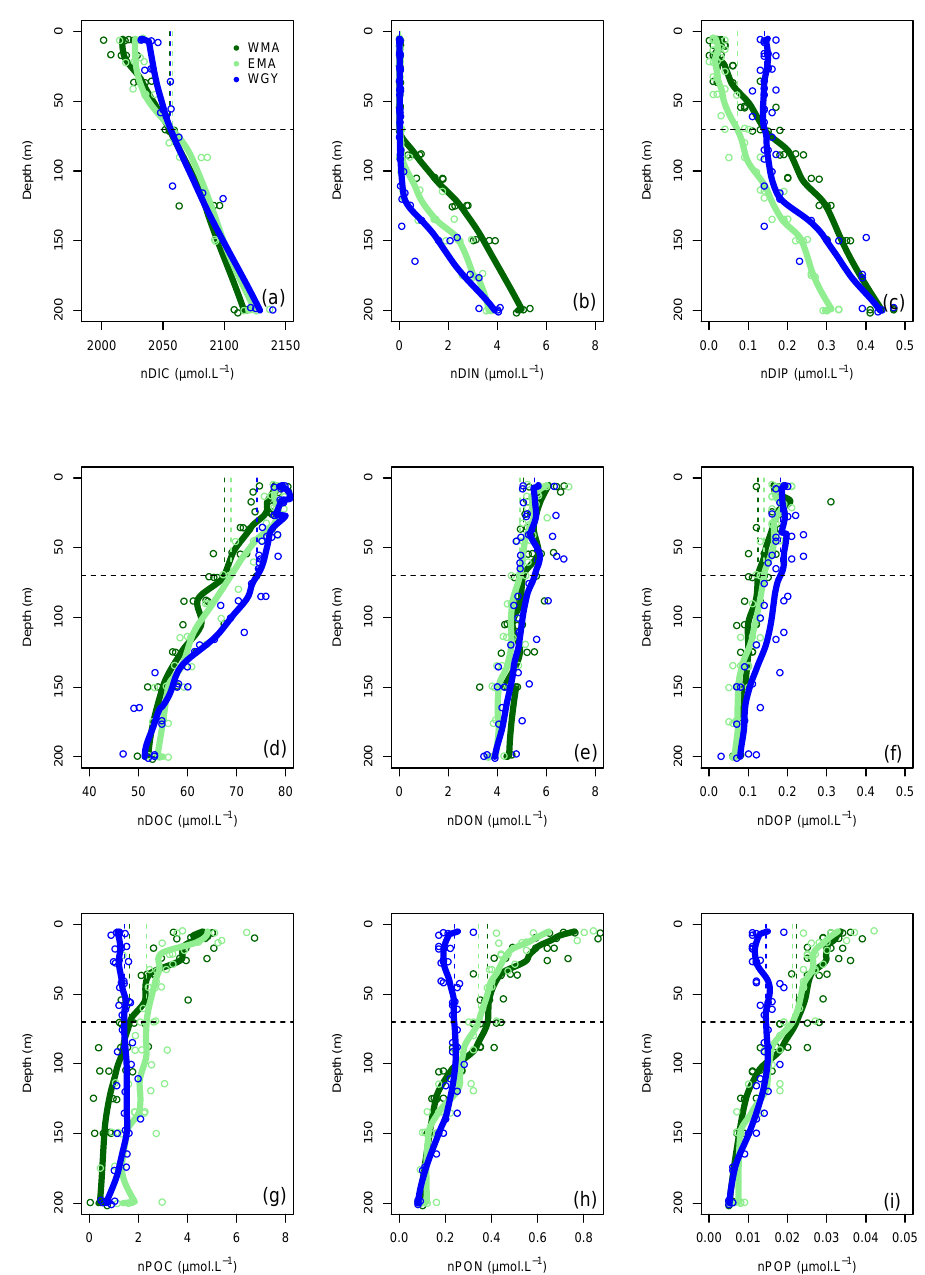
Figure 5. Vertical profiles of normalized (n) C, N, and P data against depth (m). Dissolved inorganic (DI), dissolved organic (DO) and particulate organic (PO) C (a, d, g) , N (b, e, h) , and P (c, f, i) , respectively, in µmolL − 1 , for the three distinct areas sampled during the OUTPACE cruise: the western Melanesian Archipelago (WMA in dark green), the eastern Melanesian Archipelago (EMA in light green), and the western SP gyre (WGY in blue). The horizontal dashed lines indicate the mixed layer depth of 70m. The vertical dashed lines indicate the upper surface expected values for all variables during the 2014 austral